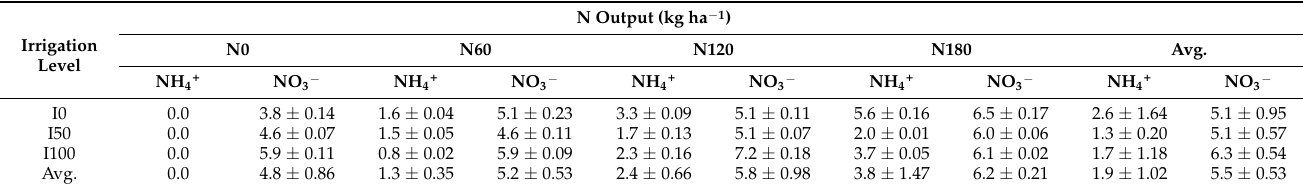
(on average 5.5 kg ha − 1 ), with differences among the irrigation treatments (Table 4). Table 4. N output through ammonia emissions and nitrate leaching (kg ha − 1 ) in relation to the experimental factors (I0, I50, I100 = 0, 50, 100% ETc, respectively; N0, N60, N120, N180 = 0, 60, 120, 180 kg ha − 1 N, respectively). Values of the standard error are reported.